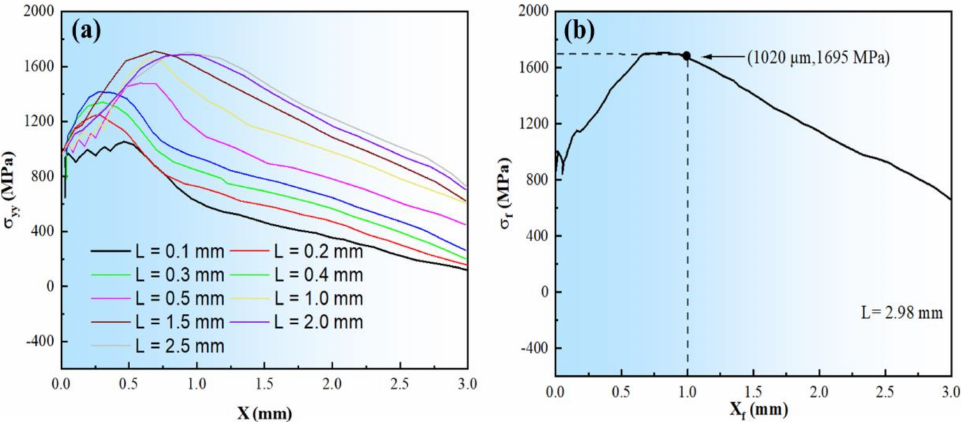
Figure 10. ( a ) The stress distribution at the central axis of v − notch front under different flexible L of three-point bending head and ( b ) the fracture stress at deflection amount of 2.98